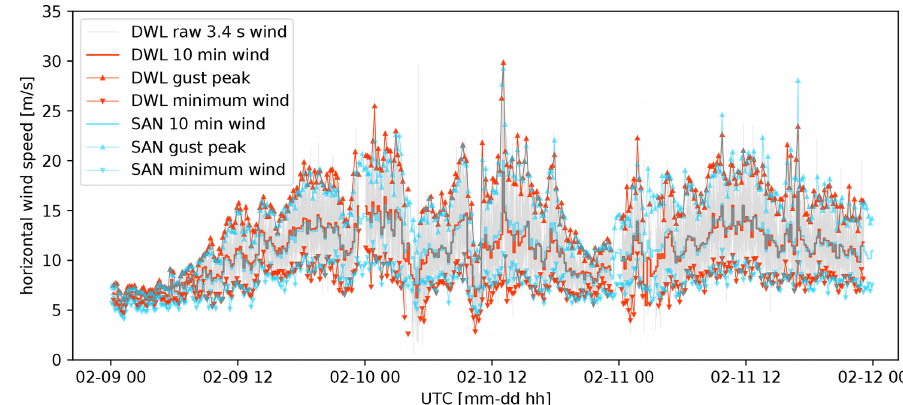
Figure 9. Time series of wind speeds during extratropical storm Sabine on 9–11 February 2020. Both the DWL operated in CSM2 (red) and sonic anemometer (SAN, cyan) winds are shown. The triangles indicate the 10min gust peaks and wind minima, the thicker step-like lines indicate the 10min mean horizontal wind, and the light grey line shows the results for all processed DWL cycles. Very good agreement between the data means that markers and lines completely overlap. Note that due to outlier filtering, not all cycle maxima and minima match the gust peak and wind minimum values, respectively.